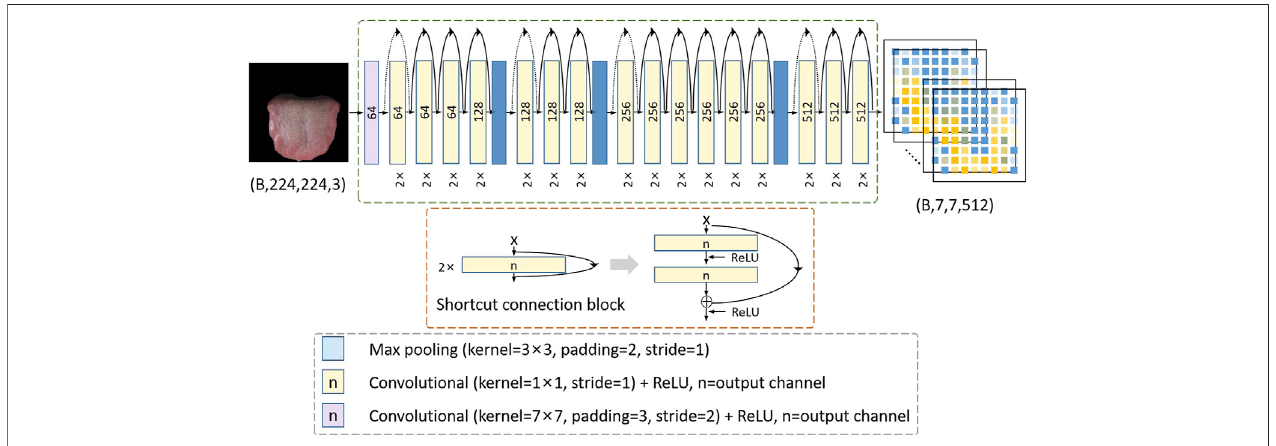
FIGURE 5 | Architecture of the ResNet34 model. The size of tongue images and deep features are expressed as (batch size, width, height and channel). The solid line residual arrow indicates that the input and output have the same dimension, and the dotted line residual arrow indicates that the input and output have different